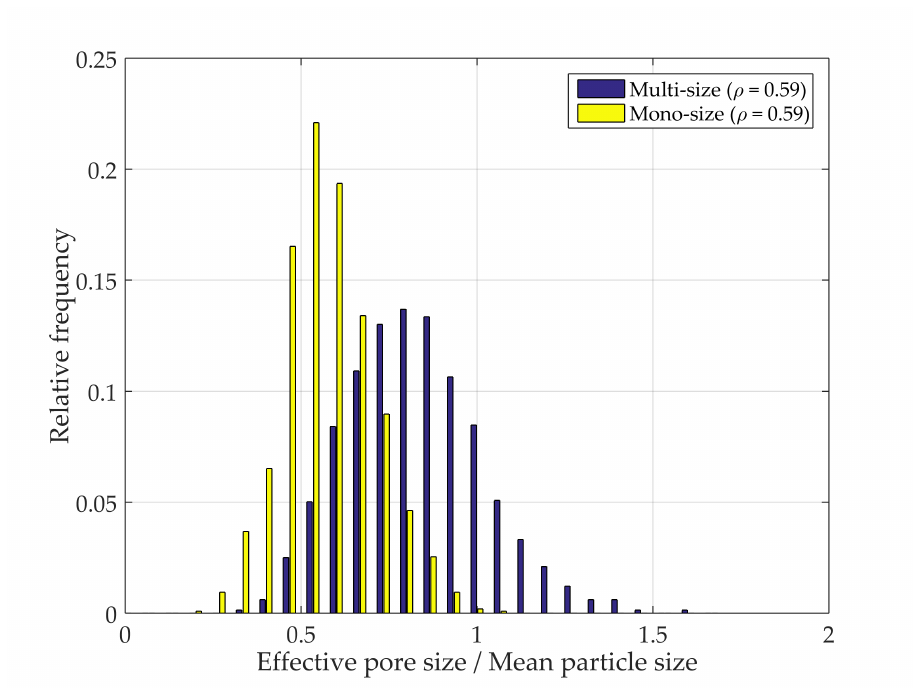
Figure 15. PSD multi mono.